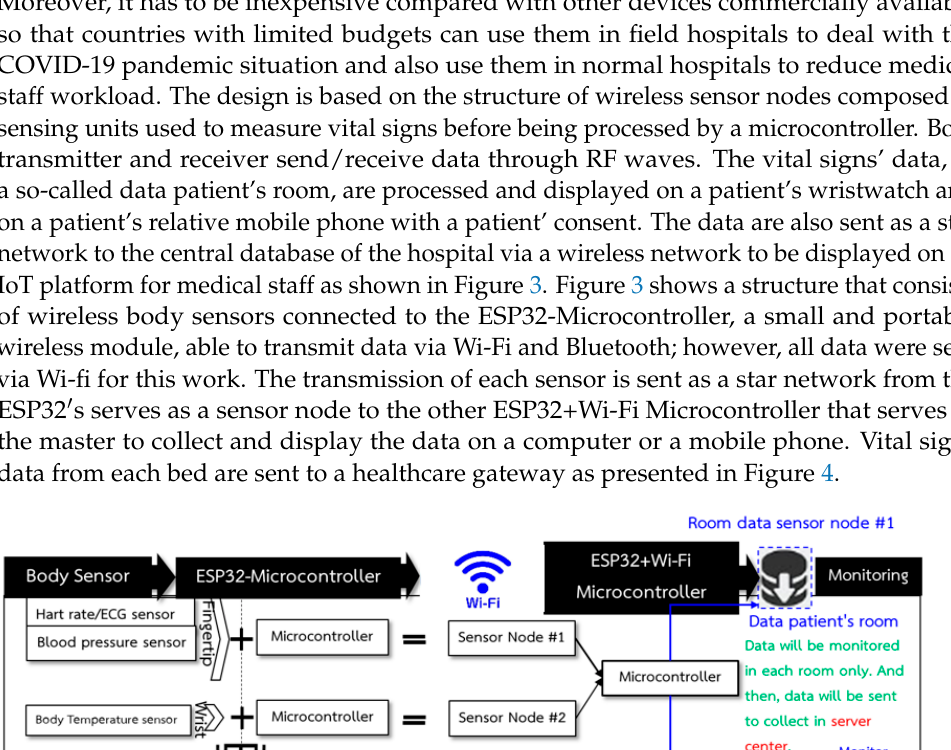
Figure 5. A structure of the communication between sensor node and room data sensor node (#I.D.) to the healthcare database center.